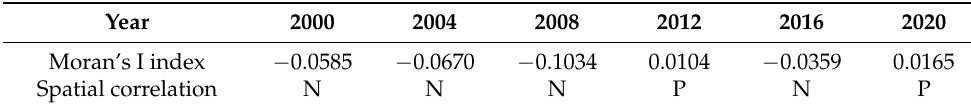
Table 3. Moran’s I indices of EGC and ER in the YRD region.